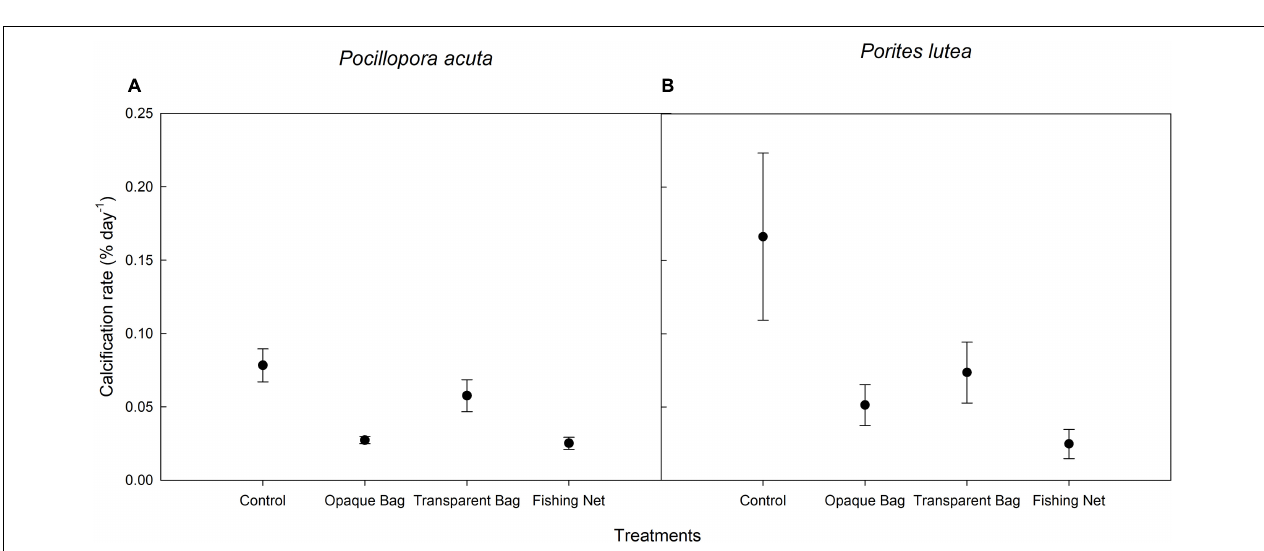
FIGURE 6 | Zooxanthellae density of P. acuta (A) and P. lutea (B) in control, opaque bag, transparent bag, and fishing net treatments at week 2 and week 4 of experiment. Data are presented as Mean ± SE ( n = 6). a, b, and c indicate significant difference.